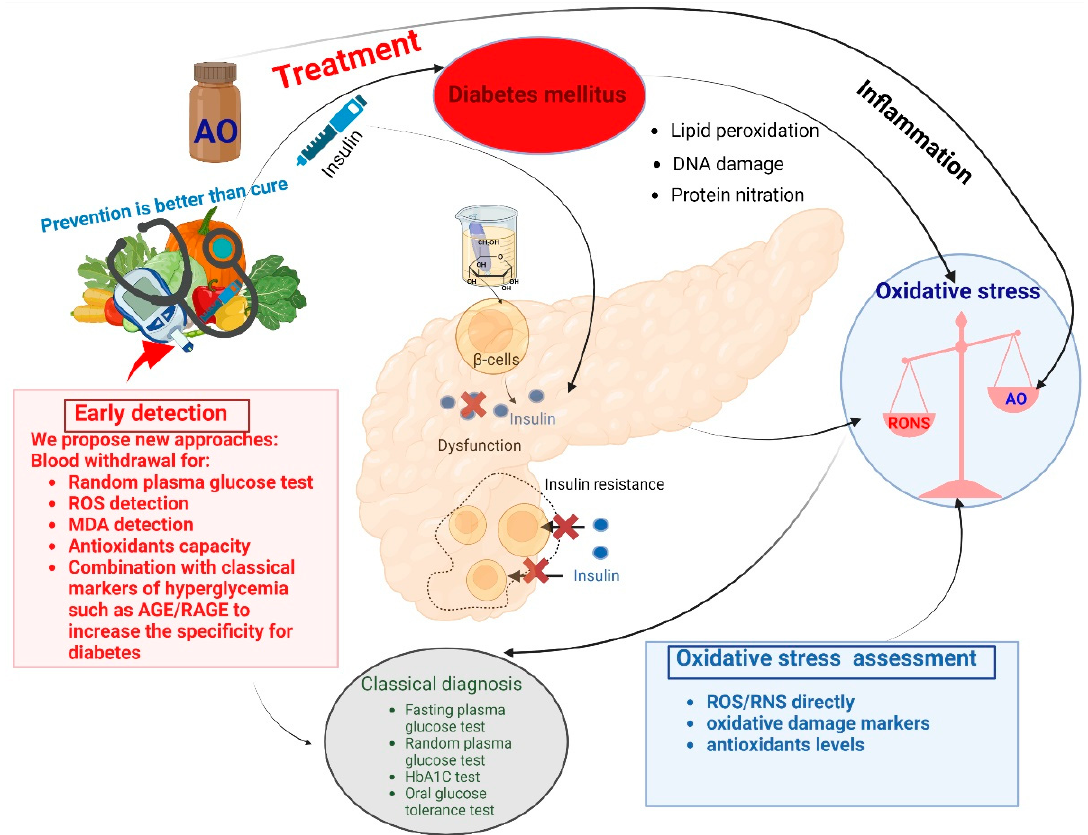
Figure 10. Schematic overview of the proposed methods. AO, antioxidants; DNA, deoxyribonucleic acid; MDA, malondialdehyde; RNS, reactive nitrogen species; RONS, reactive oxygen and nitrogen species; ROS, reactive oxygen species. The figure is drawn with Biorender.